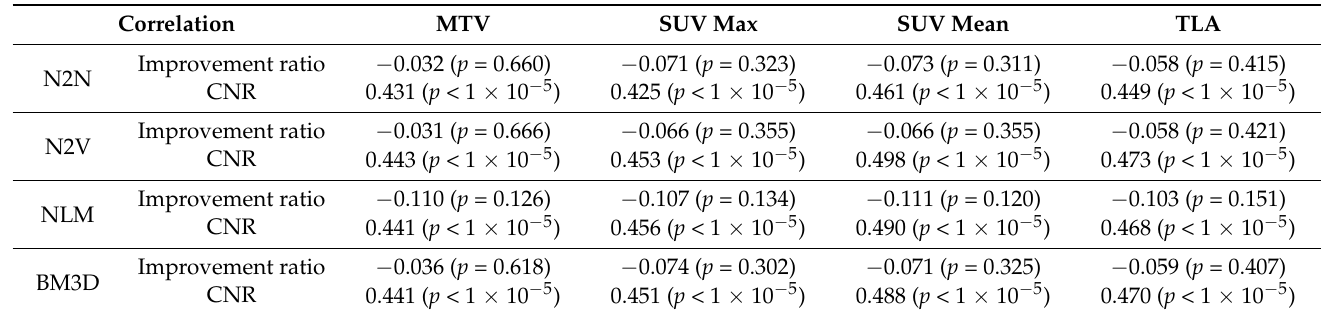
Table 5. Correlation of CNR and CNR improvement ratio with MTV, SUVmax, SUVmean and